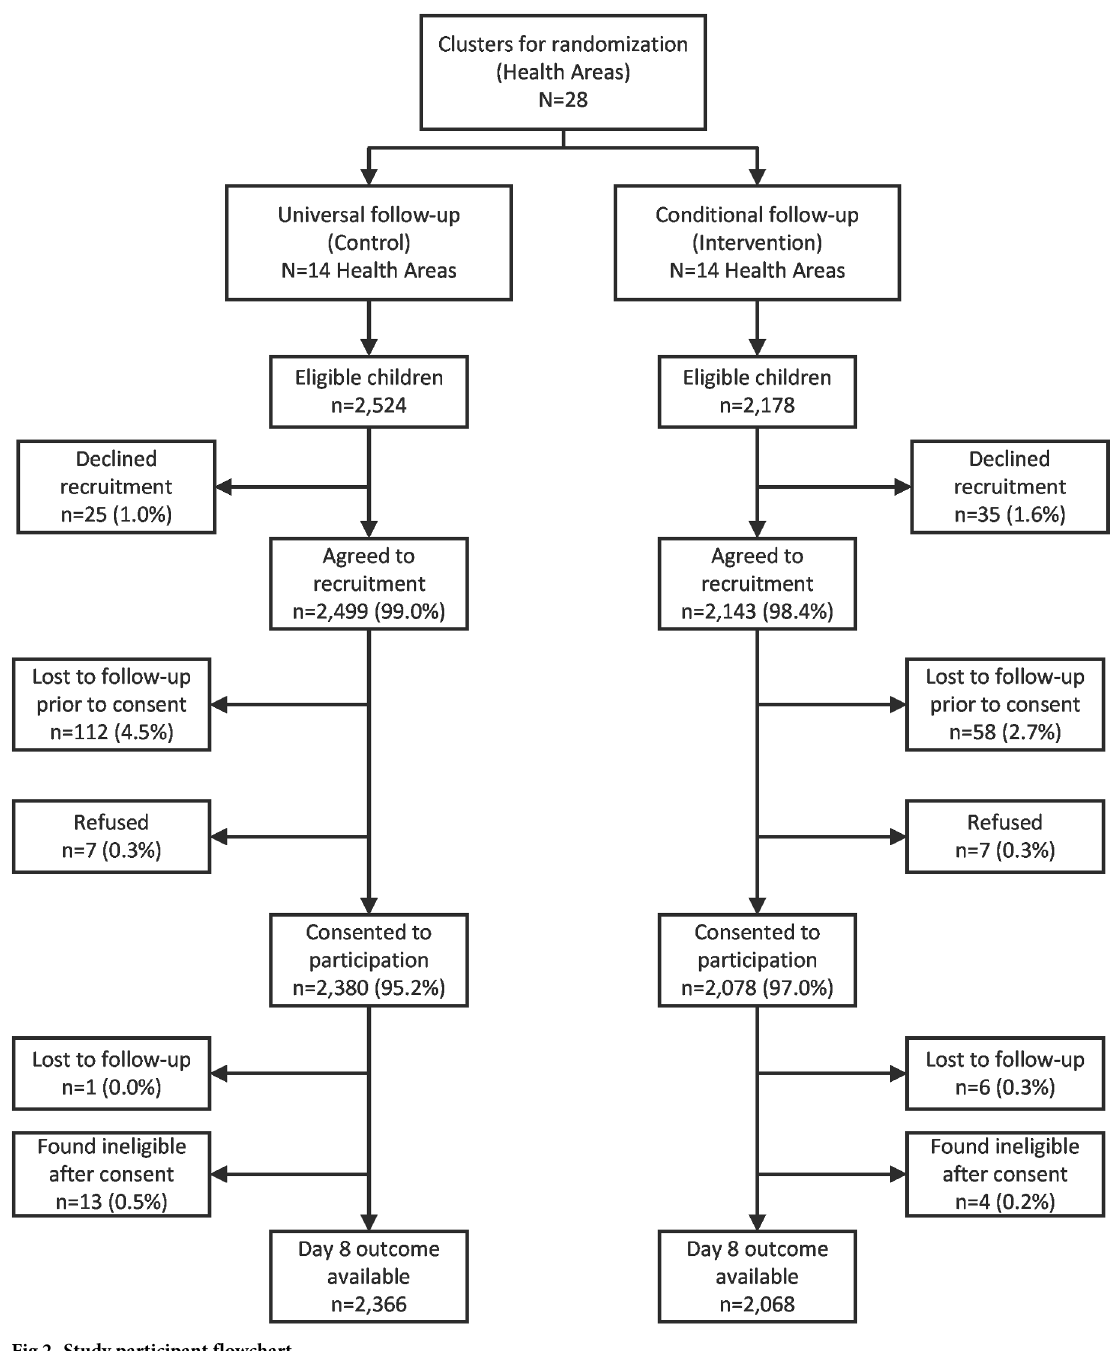
Fig 2. Study participant